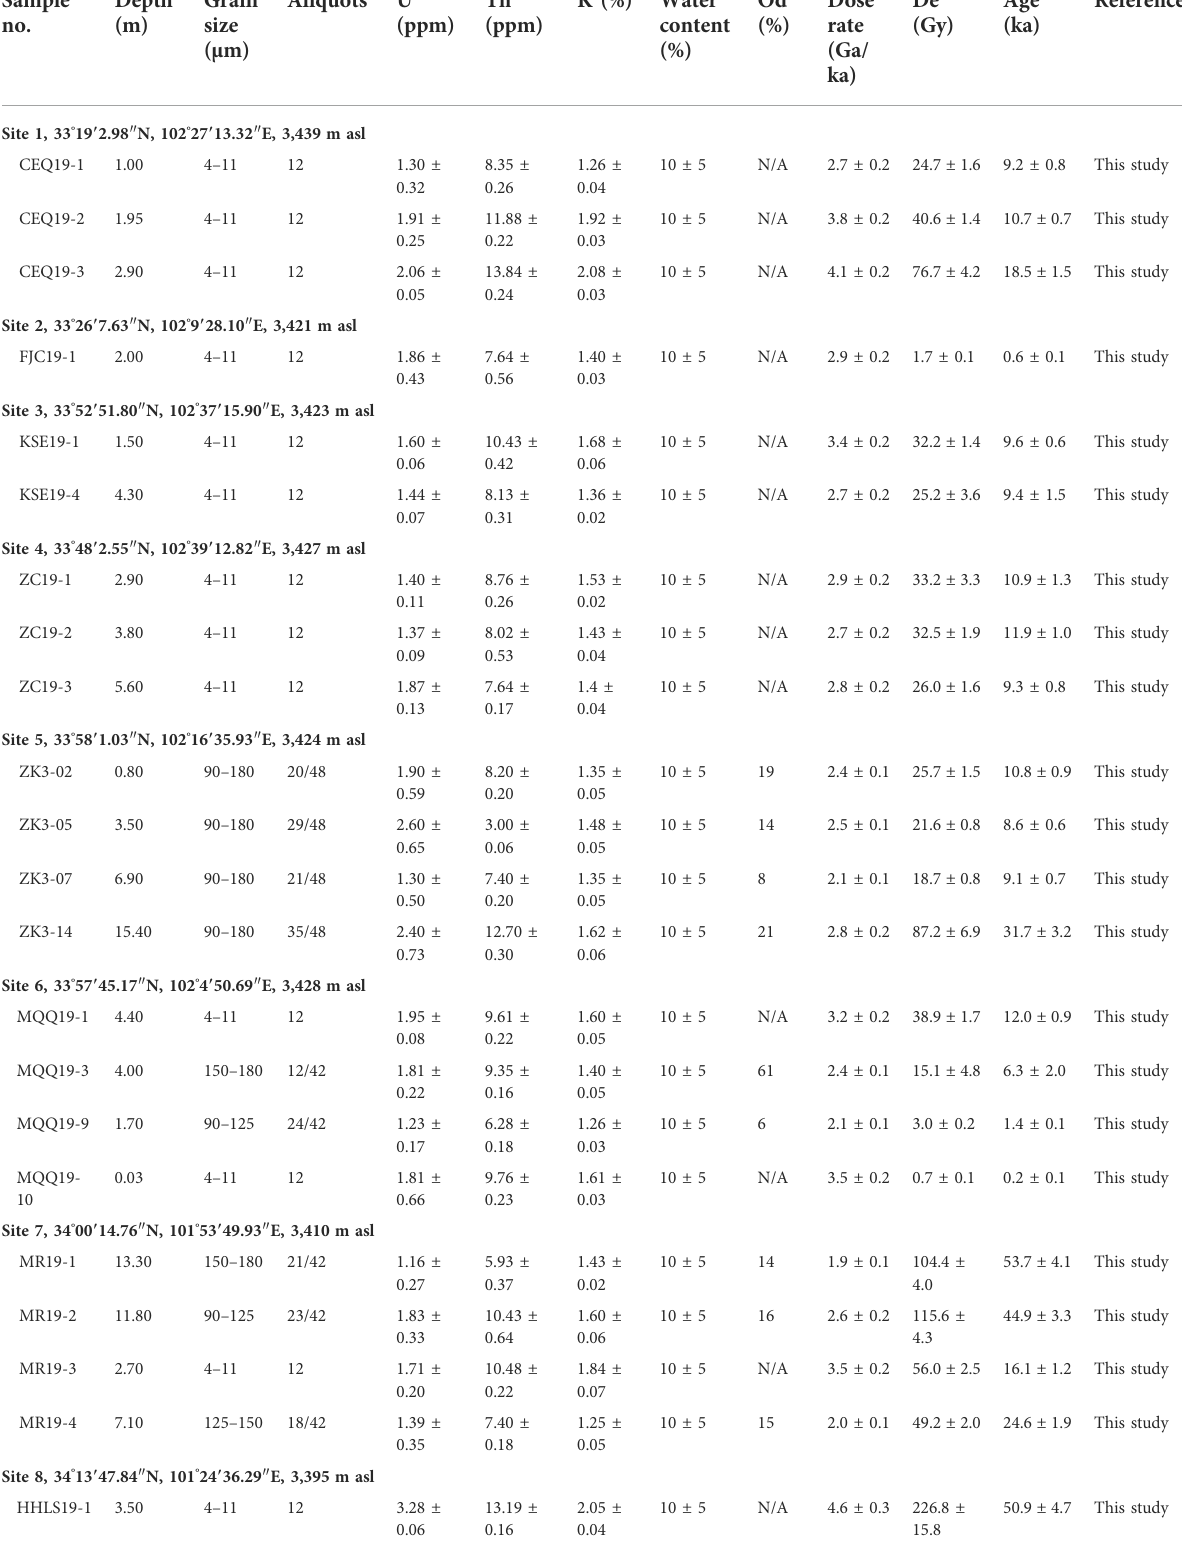
TABLE 1 OSL dating results of sediments in the Caiyima-Ningmut section of the Yellow River source. Sample